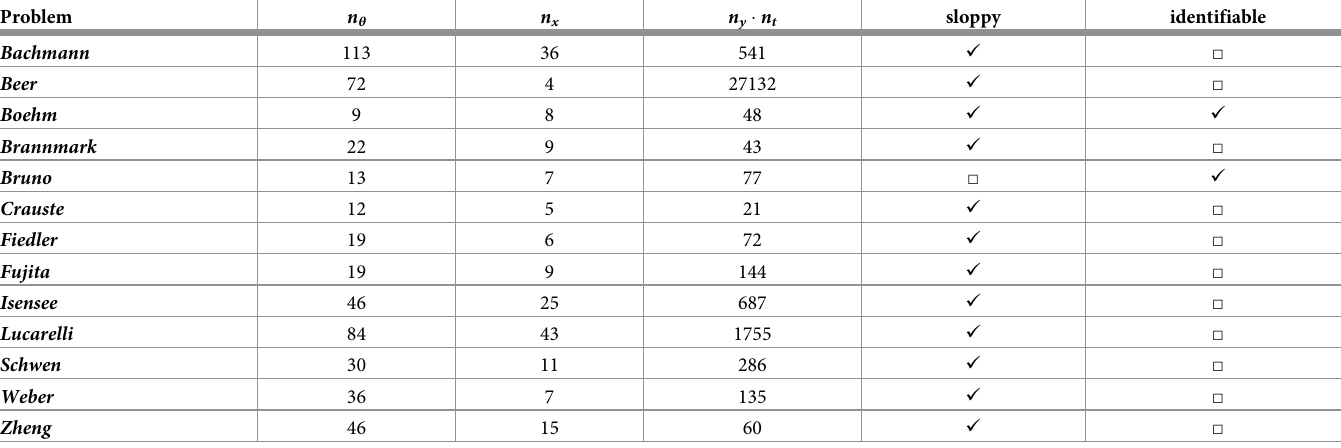
Table 3. Summary of problem characteristics for benchmark examples, as characterized by Hass et al . [15]. Problem n θ n x n y � n t sloppy